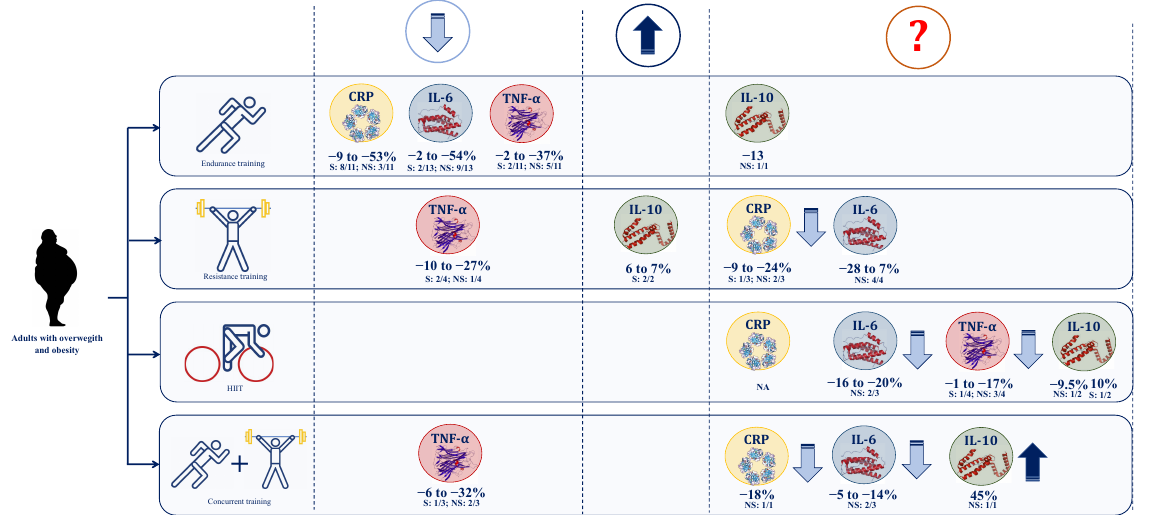
) increased and ( ) decreased circulating ↑ ↓